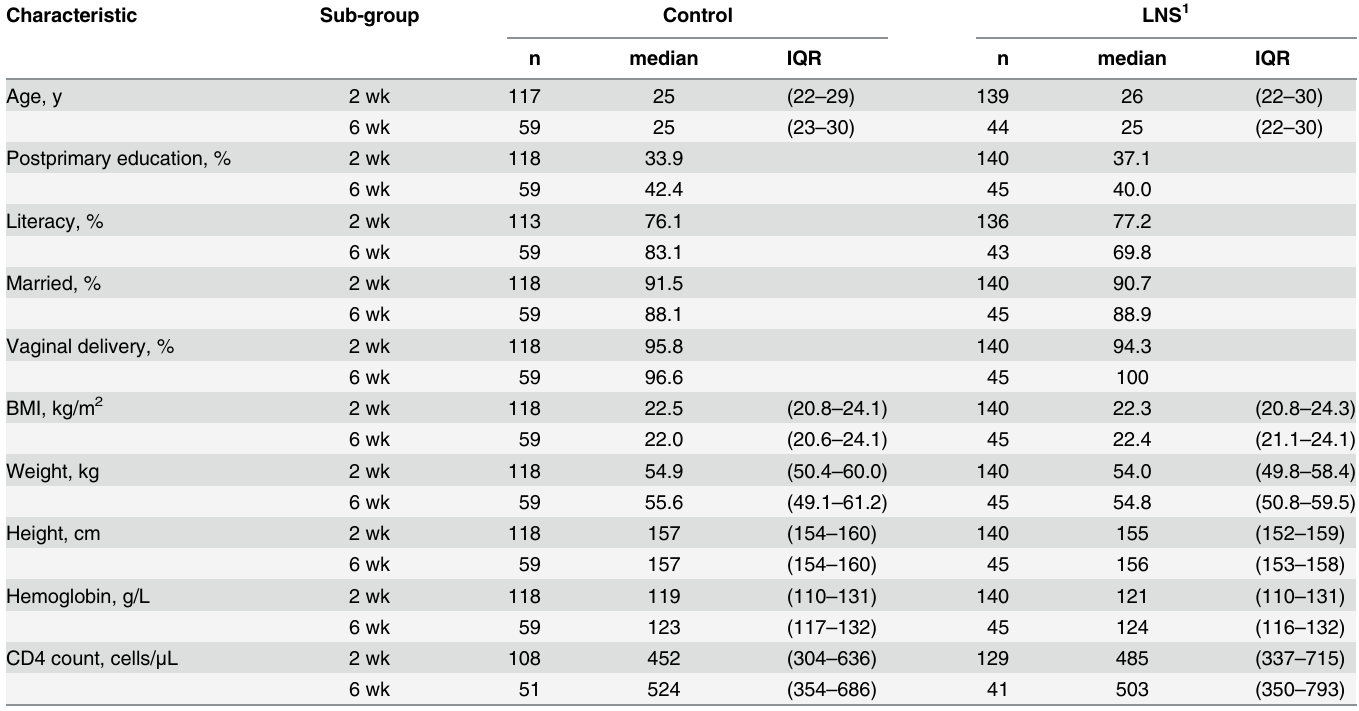
Table 2. Characteristics of participants in the Breastfeeding, Antiretrovirals, and Nutrition (BAN) study at the initial time point (no significant differ- ences within and between subgroups). Characteristic